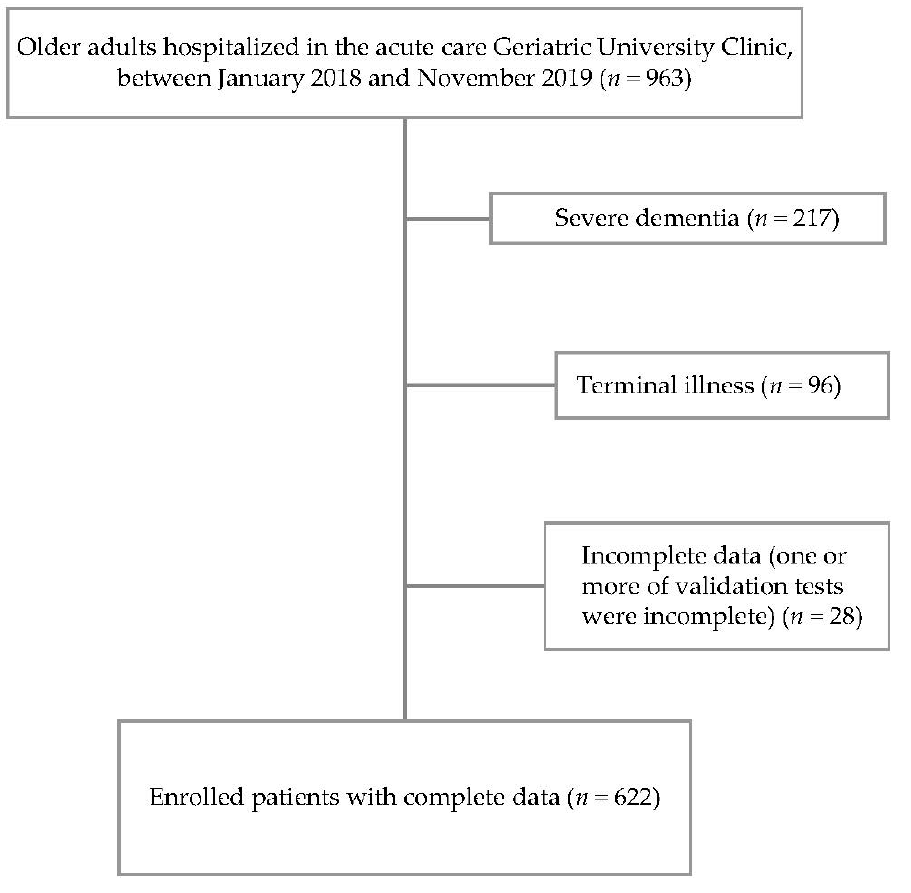
Figure 1. Flow chart of enrollment for the study.